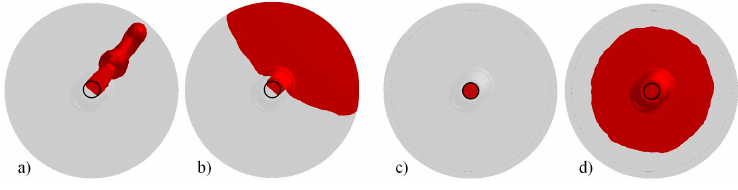
Figure 6. Bottom view of the steel entering the mold in case of: complete model ( a , b ); and simplified model ( c , d ).